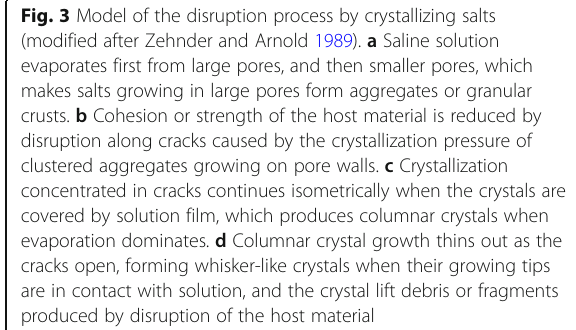
Fig. 3 Model of the disruption process by crystallizing salts (modified after Zehnder and Arnold 1989). a Saline solution evaporates first from large pores, and then smaller pores, which makes salts growing in large pores form aggregates or granular crusts. b Cohesion or strength of the host material is reduced by disruption along cracks caused by the crystallization pressure of clustered aggregates growing on pore walls. c Crystallization concentrated in cracks continues isometrically when the crystals are covered by solution film, which produces columnar crystals when evaporation dominates. d Columnar crystal growth thins out as the cracks open, forming whisker-like crystals when their growing tips are in contact with solution, and the crystal lift debris or fragments produced by disruption of the host